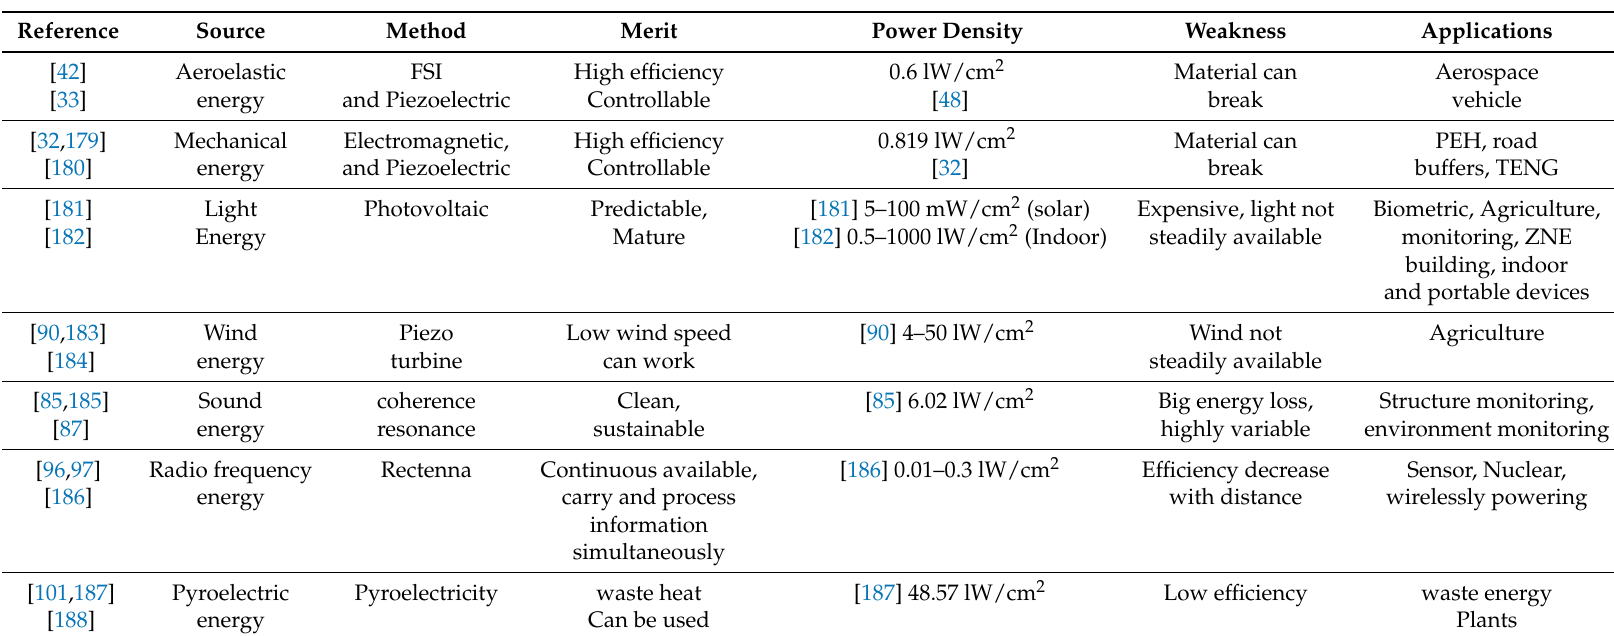
Table 7. Comparison of energy harvesting